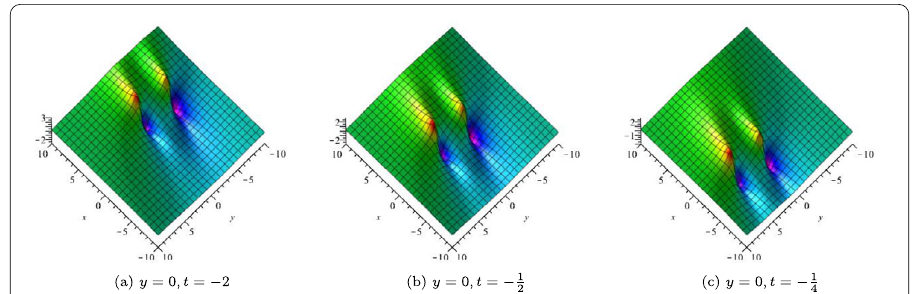
Figure 9 Two-lump solutions for Eq. (1.2) in the ( x , y ) plane with the parameters defined in Eq. (2.19)